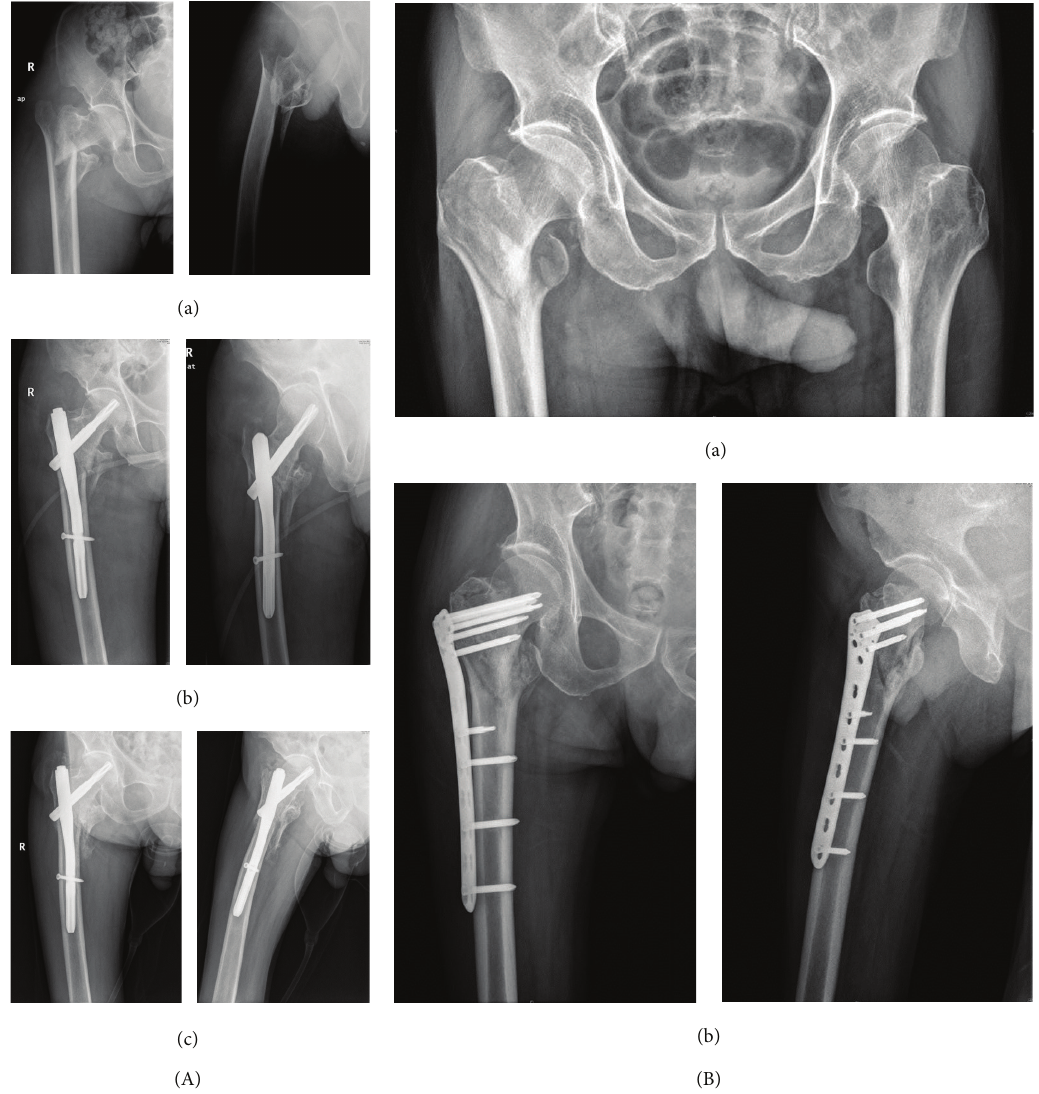
Figure 2: Patients with 31 A2 fractures. (A) PFNA (A(a)) Preoperative AP view and lateral view. (A(b)) Immediate postoperative AP view and oblique view. (A(c)) Three months postoperatively. Callus formation can be seen in both AP view and oblique view. (B) Reverse LISS (B(a)) Preoperative AP view. (B(b)) Immediate postoperative AP view and lateral